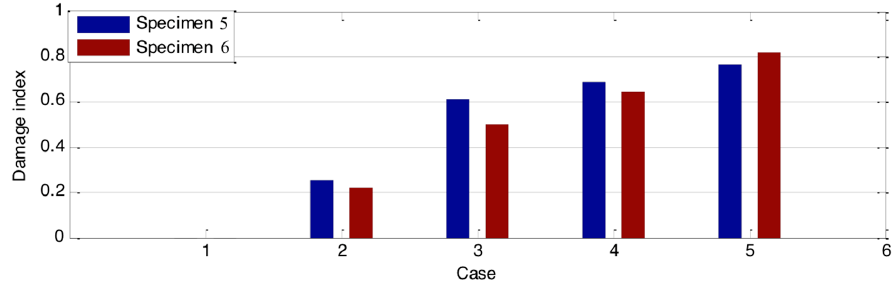
Figure 9. Damage indices of timber with different hole diameters.